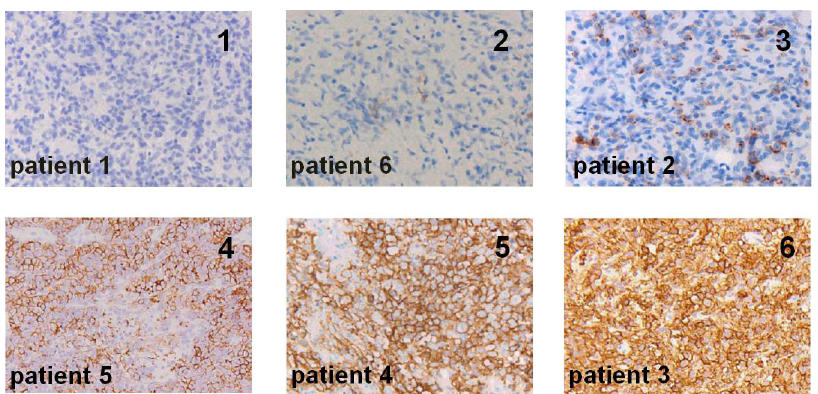
Fig 2. Biopsies ranked in order of increasing CD20expression. Per panel the CD20rank is indicatedin the right upper corner and the patient numberin the left lower corner. 1) Core-needle biopsy of DLBCL